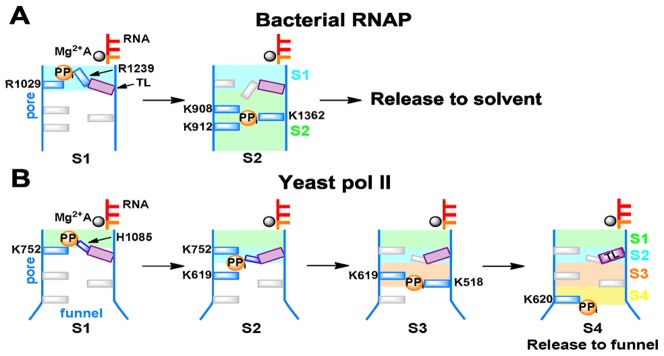
Cartoon models of the PPi release in RNAP (A) and Pol II (B).